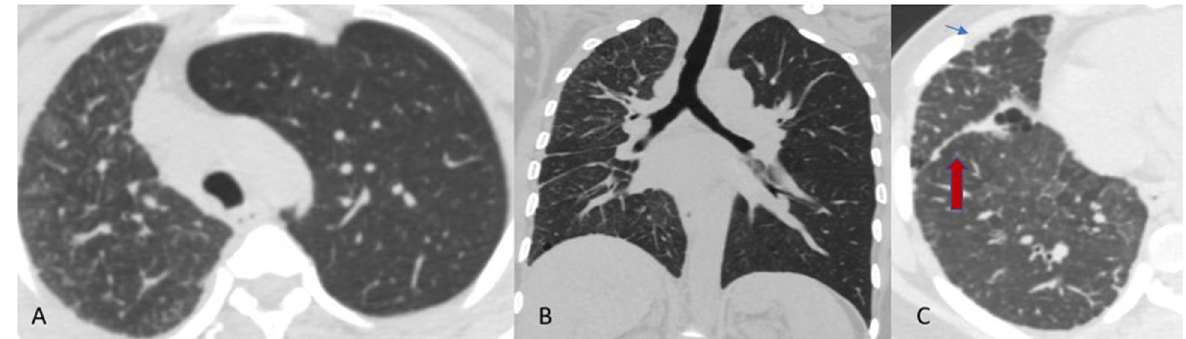
Fig. 2 HRCT thorax (A-axial, B-coronal and C-axial) Lung window reveals small-sized right hemithorax, compensatory overinflation of left lung with mild mediastinal and tracheal shift towards right and elevation of right hemi diaphragm, thickening of right oblique fissure (marked by red arrow) and septal thickening (marked by small blue arrow) and centrilobular ground glass densities in right